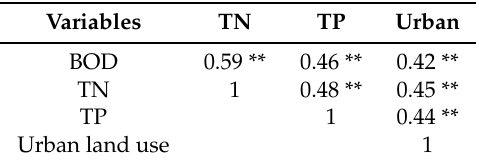
Table 2. Pearson-correlations between the proportion of urban land use and water quality indicators. All variables used in the study displayed strong correlations with each other.